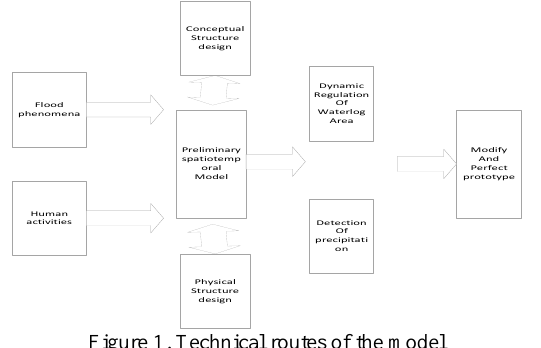
Figure 1. Technical routes of the model